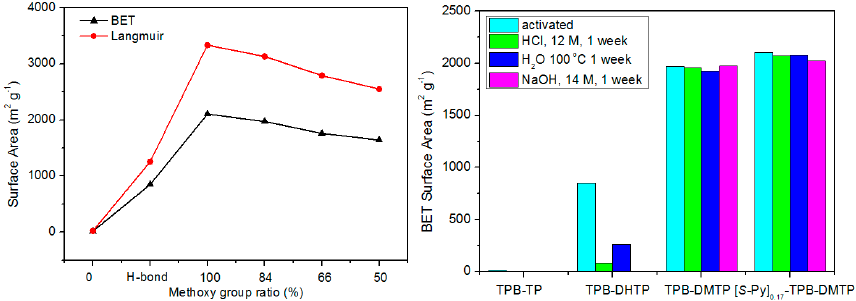
Figure 15. The surface area vs the methoxy group ratio in TPB-DMTP-COF (left). The BET surface areas of TPB-DMTP and (S)-Py-TPB-DMTP COFs use TPB-TP COF and TPB-DHTP COF as control.